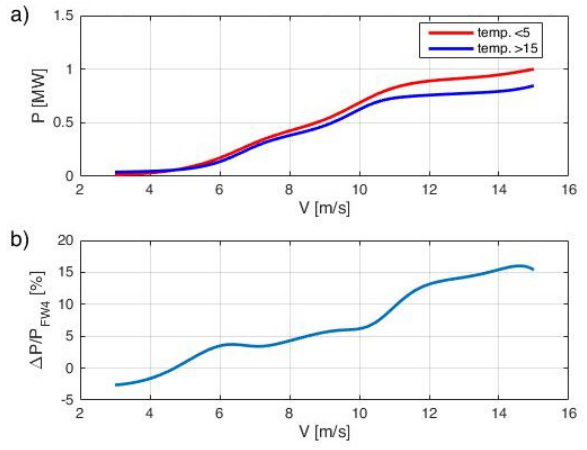
Figure 10. Wind power plant FW4: ( a ) power characteristics for T < 5 ◦ C i T > 15 ◦ C determined using neural networks, ( b ) power plant power difference for both cases as percentage of the farm’s rated